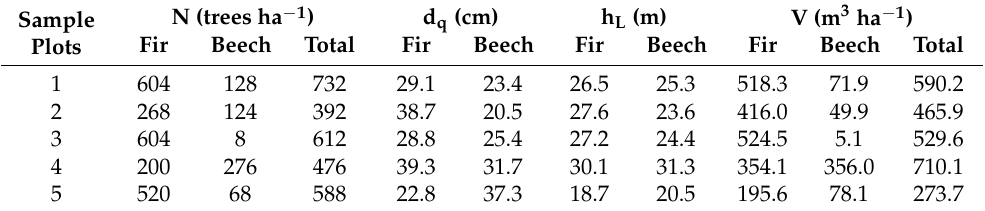
Table 1. Characteristics of sample